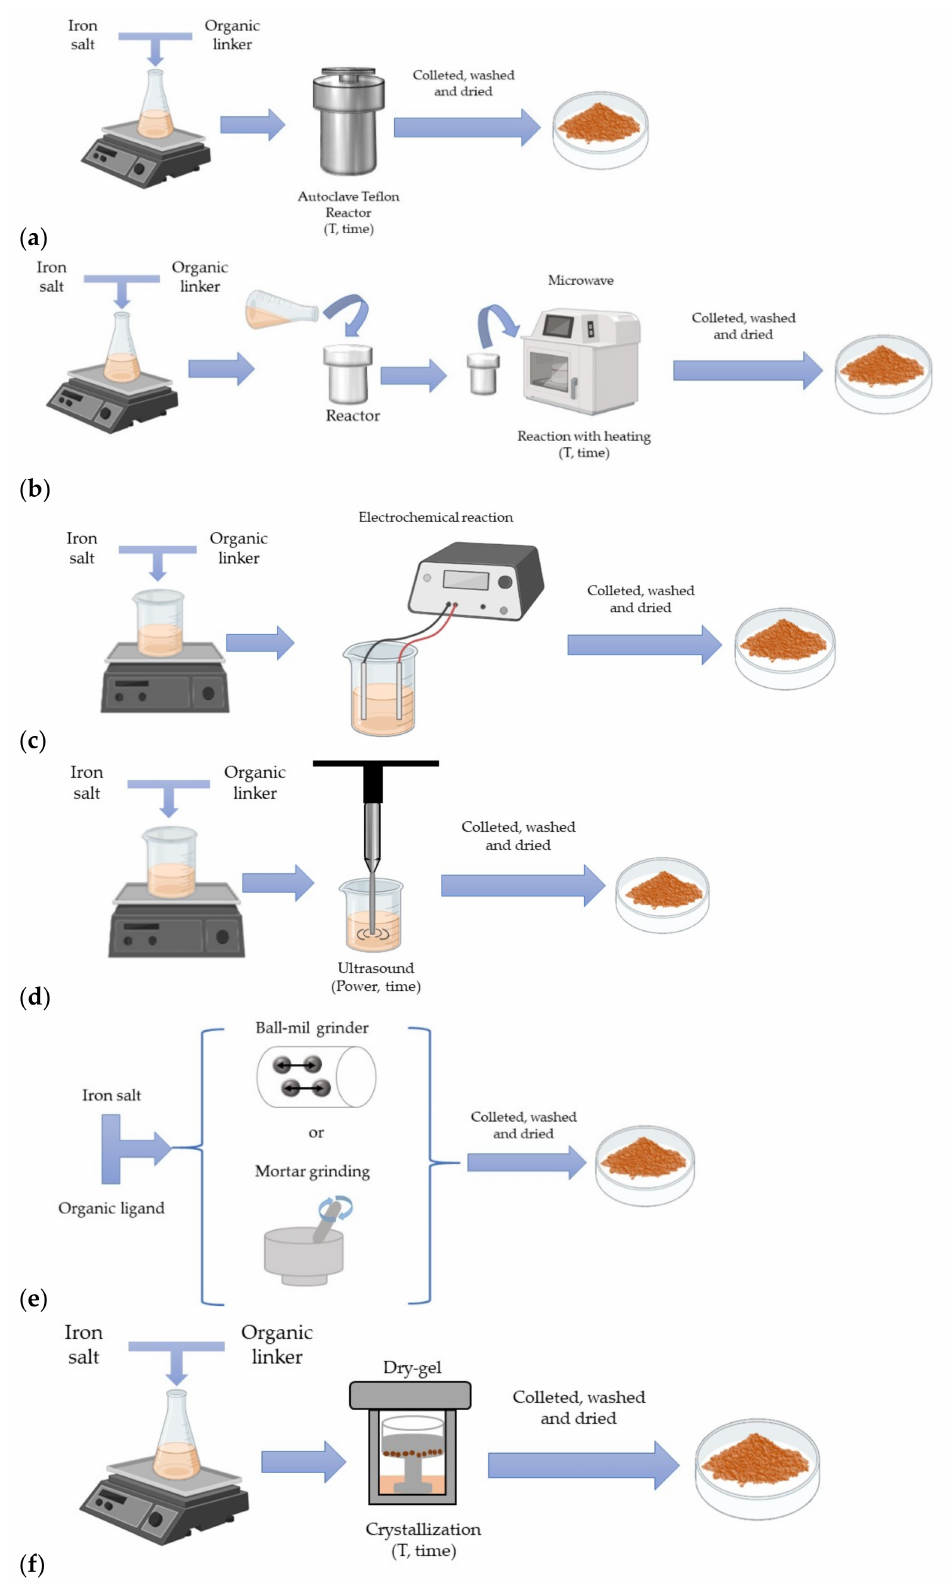
Figure 4. General scheme of ( a ) solvothermal/hydrothermal synthesis, ( b ) microwave-assisted synthesis, ( c ) electrochemical synthesis, ( d ) sonochemical synthesis, ( e ) mechanochemical synthesis, ( f ) dry-gel